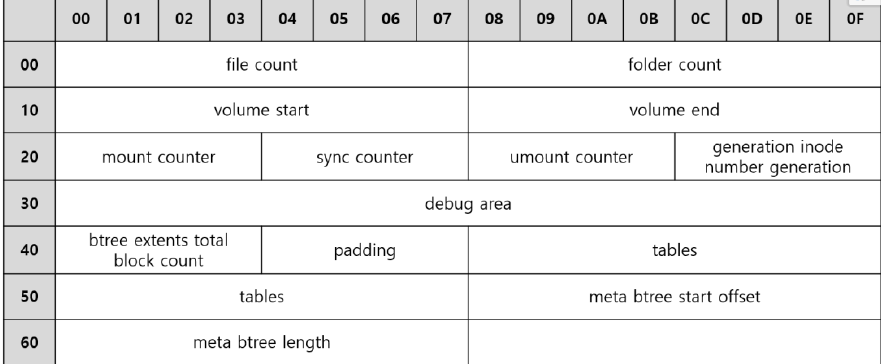
Figure 6. VDFS extended superblock structure in form of hex value.